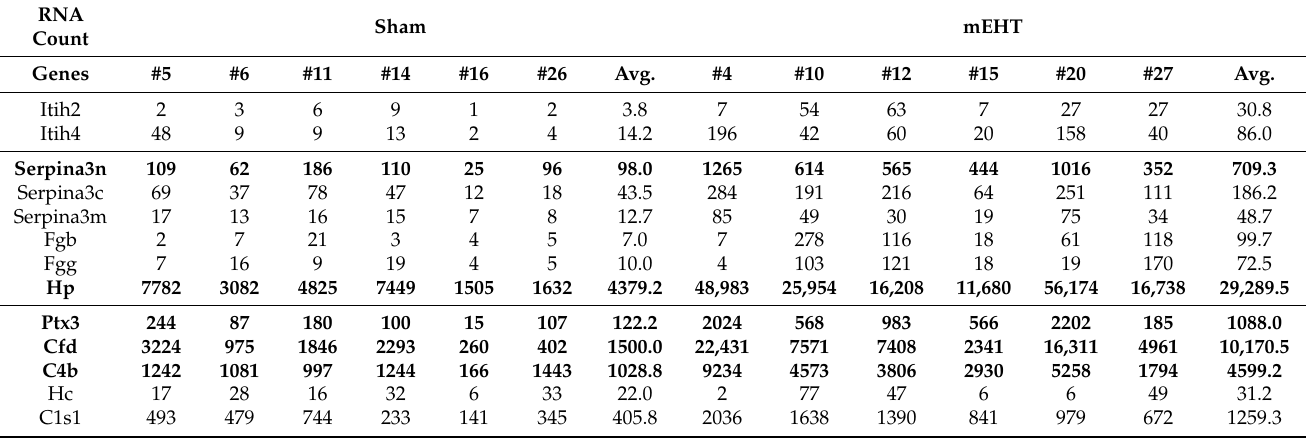
Table 1. Absolute mRNA Count of cellular stress response factors from the Nanostring data. Individual data of sham and mEHT group members and group averages. Bold letters : genes with highest mRNA absolute count and fold-change between the two groups. Background values measured in negative, synthetic probe RNA counts were between 0–16. Cell line: 4T1, 3 ×